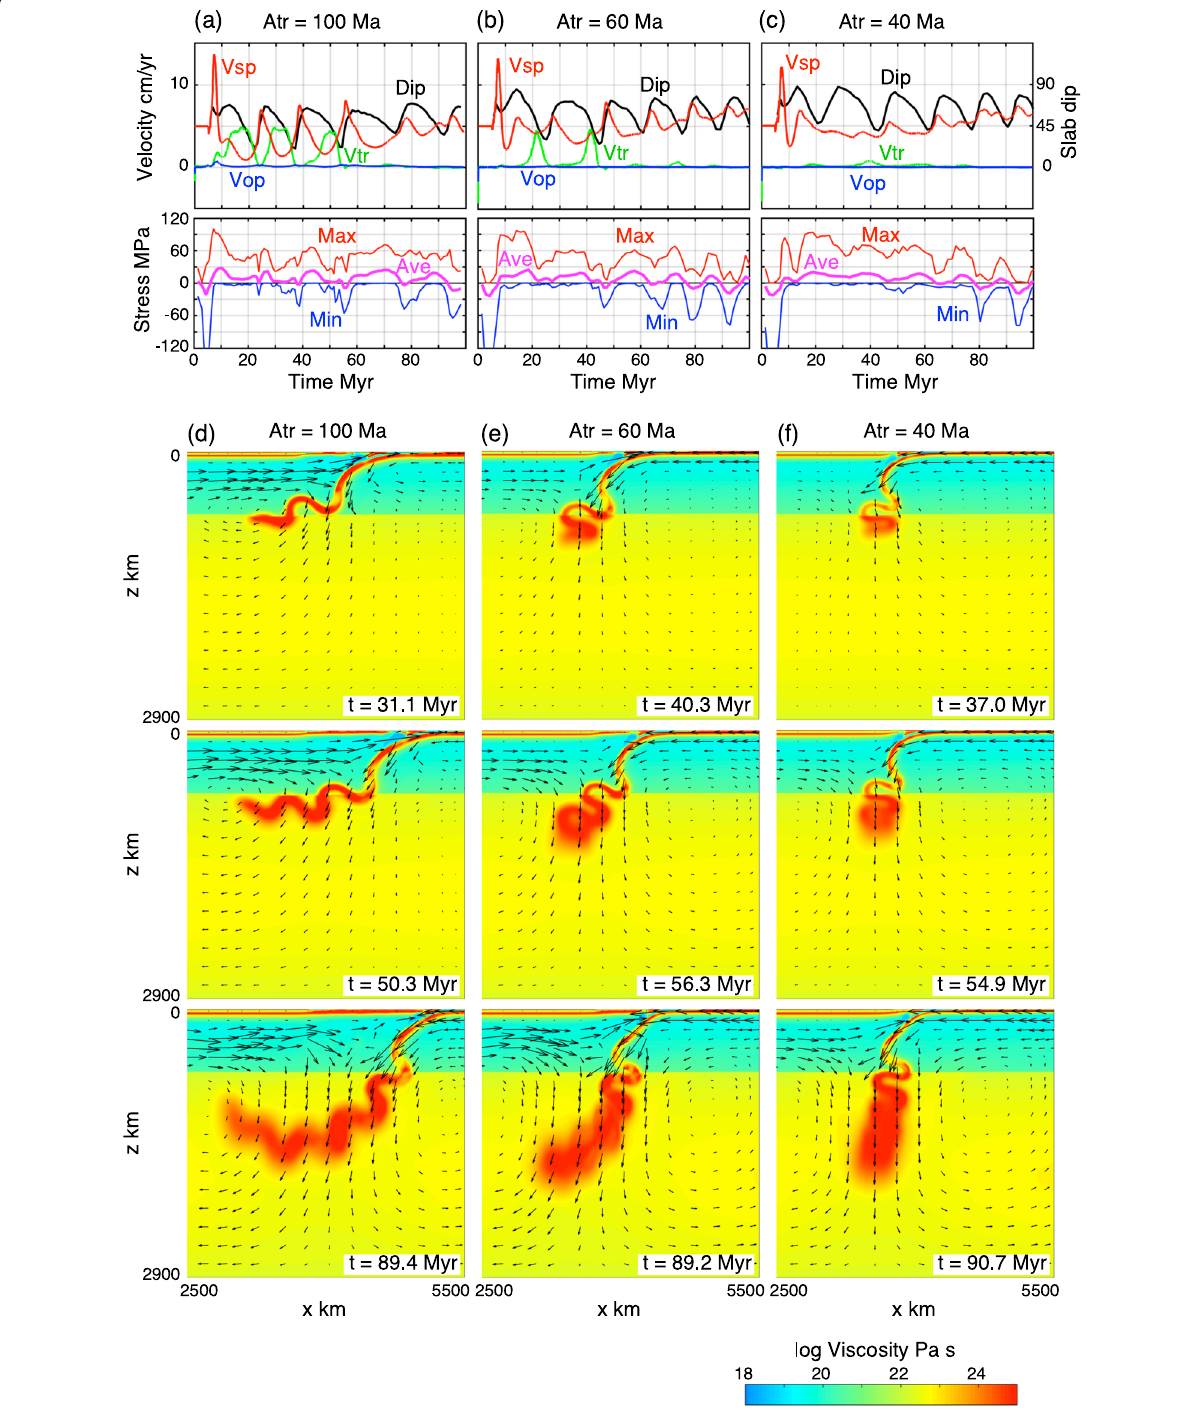
Fig. 4 Results for case 1 a , d with A tr 100 Ma, case 2 b , e with A tr 60 Ma, and case 3 c , f with A tr 40 Ma. σ yield 200 MPa and φ AL 0.1. a – c = = = = = Upper panel shows the change in velocities of the subducting plate ( V sp ), the overriding plate ( V op ) and the trench ( V tr ). The average dip angle of the slab surface (Dip) measured in the depth range of 200–300 km is also shown. Lower panel shows the change in the maximum (Max), minimum (Min) and average (Ave) values of horizontal stress in the arc area (50 km width and 30 km depth). A positive value indicates tensional stress. d – f Time evolution of the slab geometry. The distribution of effective viscosity is shown by different colors and arrows indicate the velocity